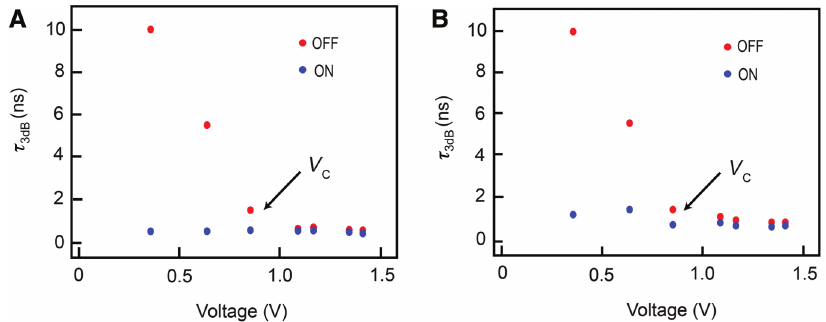
Figure 6: SPPD response times as function of the applied external bias. In the calculations, the operation wavelength is set at (A) λ = 11.2 μ m and (B) λ = 12 μ